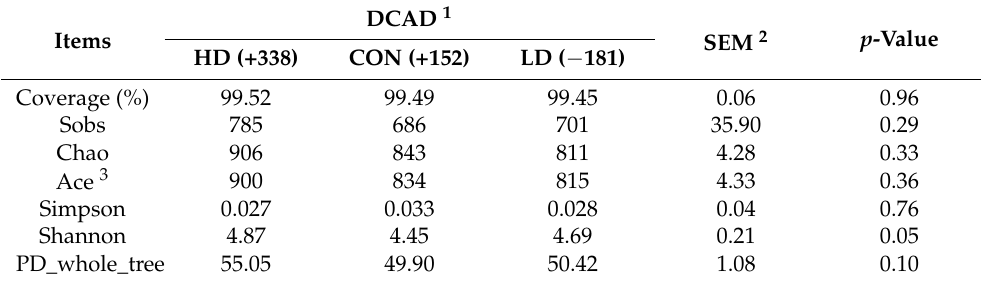
Table 4. Effect of varying dietary cation-anion difference on rumen bacterial community richness and diversity of female